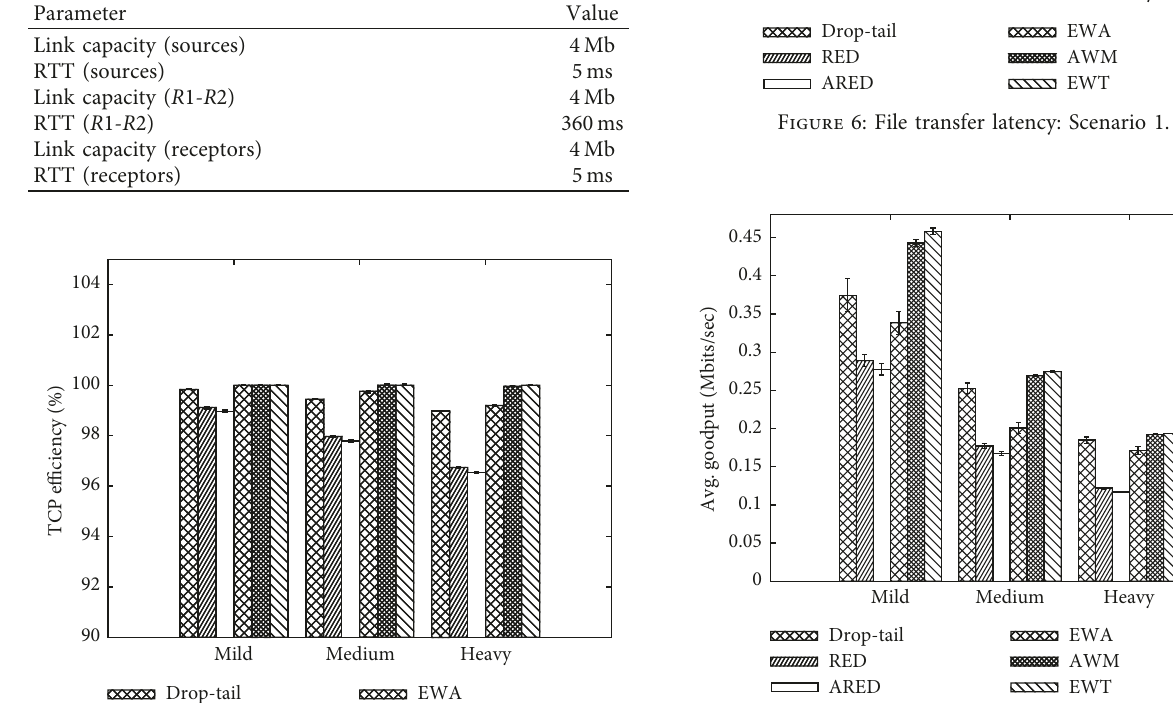
Figure 7: Average goodput: Scenario